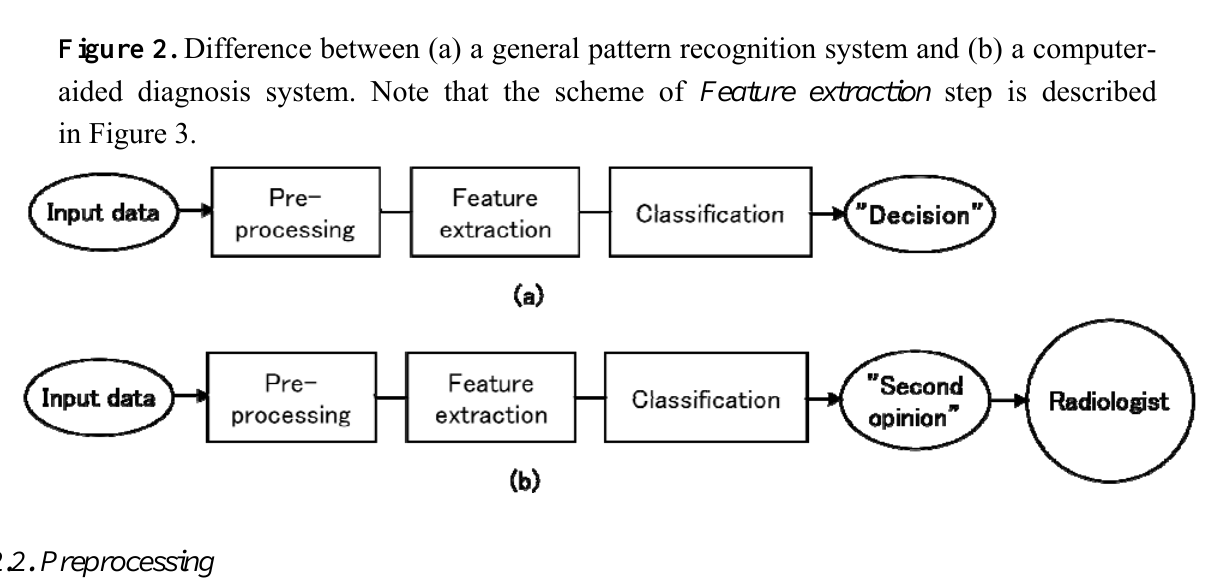
Figure 2. Difference between (a) a general pattern recognition system and (b) a